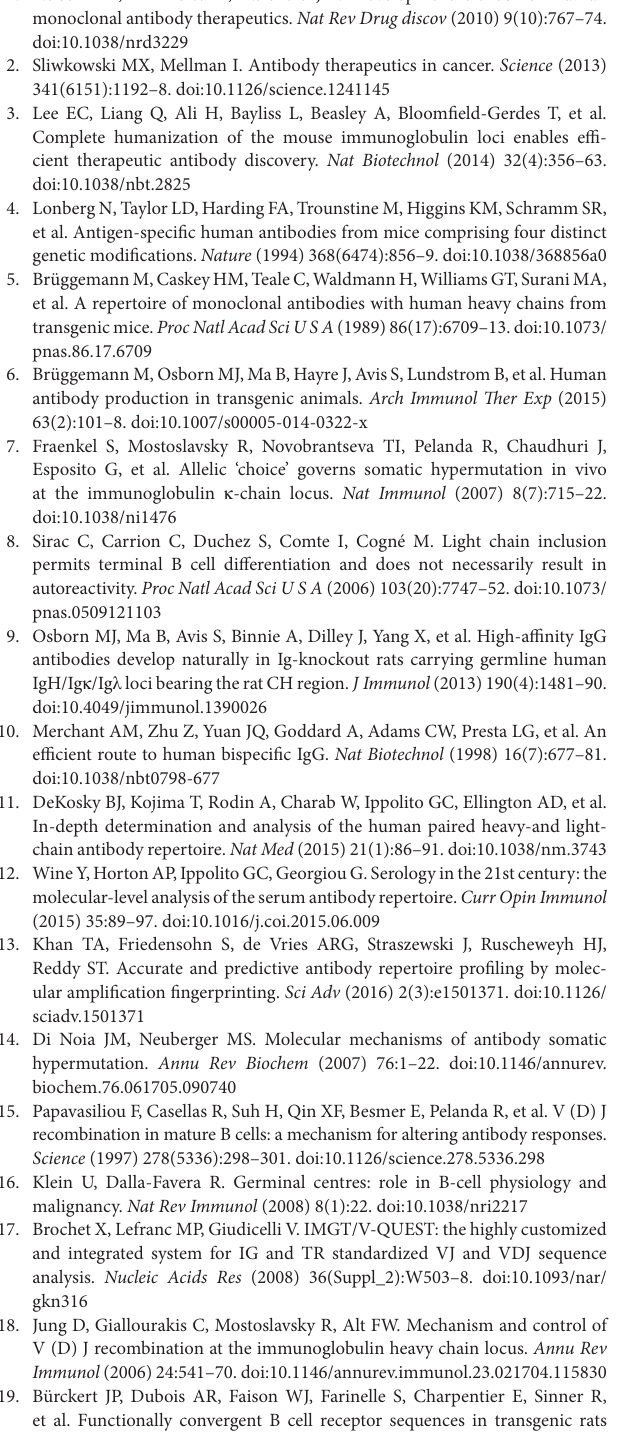
TaBle s1 | NGS sequence metrics. Basic sequence metrics for the samples analyzed are shown in this table. Column 1 indicates the unique sample identifier. Column 2 shows the total number of raw read pairs (forward and reverse reads) collected for each sample. Column 3 shows the total number of read pairs that